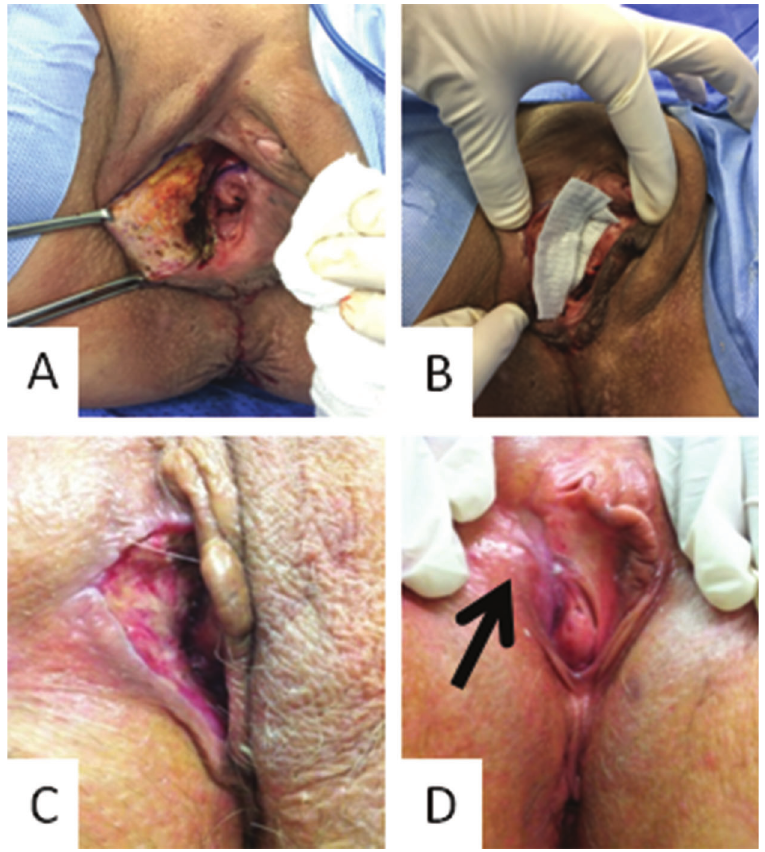
Figure 1 - Photograph of the vulvar region of a patient with the secondary healing strategy: A. Vulvar size defect after resection (immediately after surgery); B. Curative approach with the hydrofiber; C. Follow-up 2 weeks after surgery; D. follow-up 7 weeks after